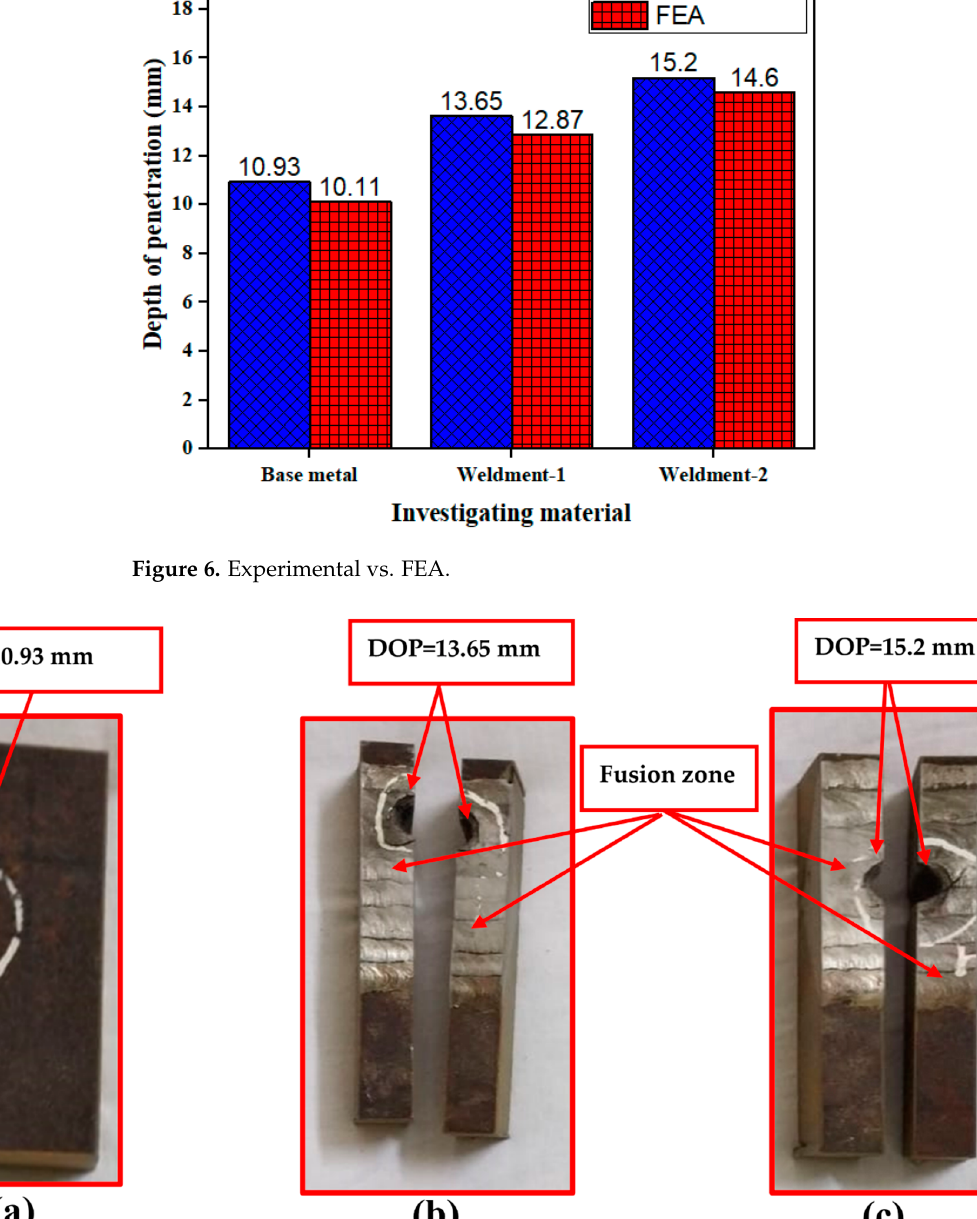
Figure 7. 7.62 AP bullet penetration cut section of ( a ) base metal, ( b ) weldment-1, ( c ) weldment-2.